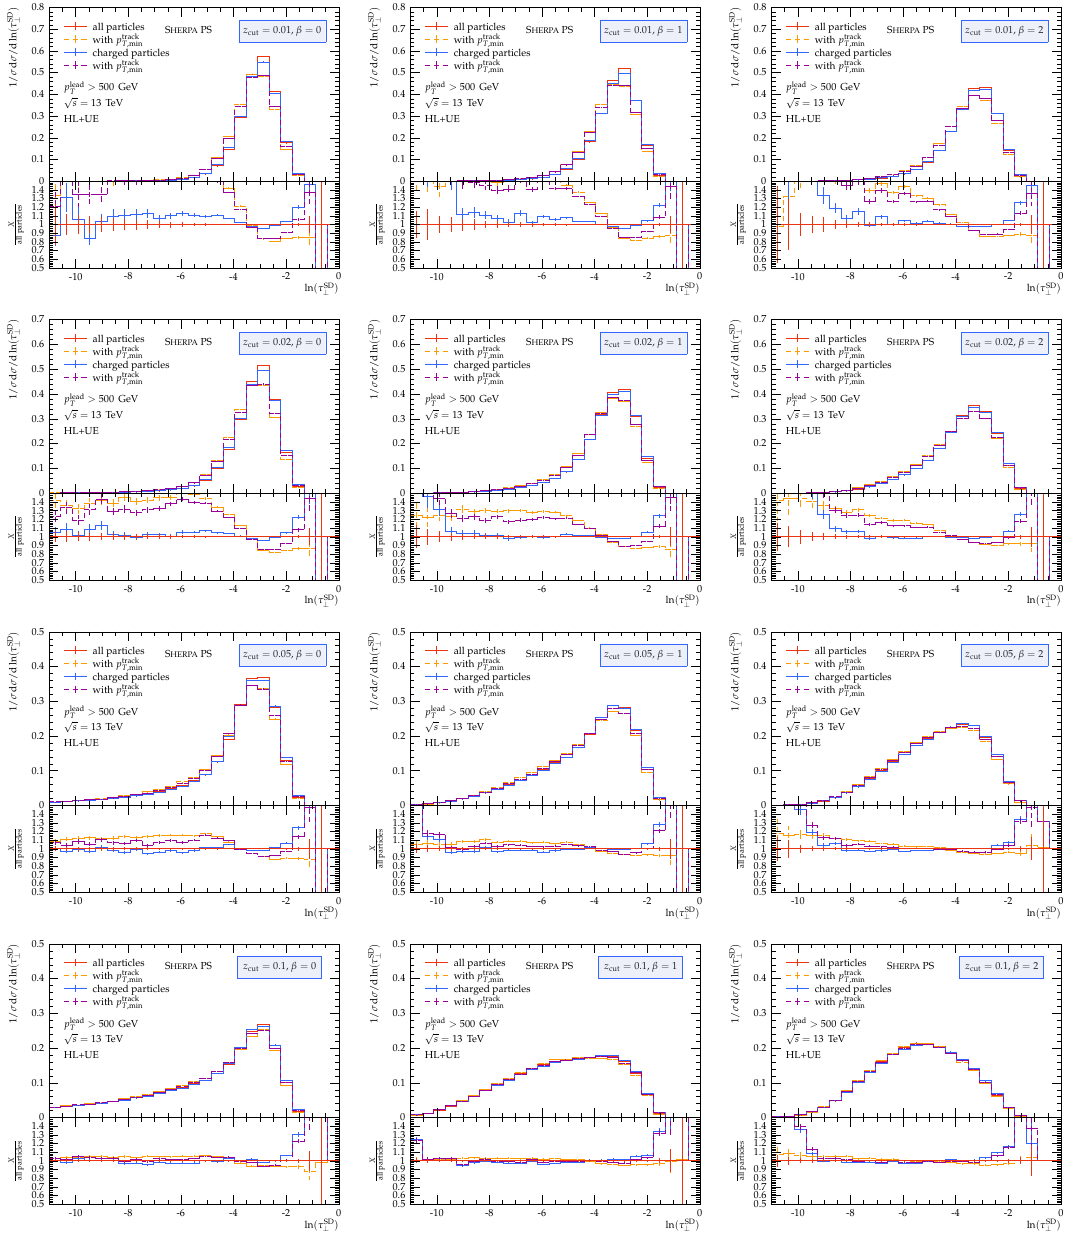
Figure 21 . Hadron-level results for groomed thrust for β ∈ { 0 , 1 , 2 } (columns) and z cut ∈ { 0 . 01 , 0 . 02 , 0 . 05 , 0 . 1 } (rows) for the p T, min = 500 GeV event selection. Shown are predictions from a parton-shower based S HERPA simulation, where the observable gets determined from all or charged final-state particles only. In addition, the effect of a minimal particle transverse-momentum cut of p track = 500 MeV is studied. The lower panels show ratios with respect to the all particles and no T, min track- p T cut